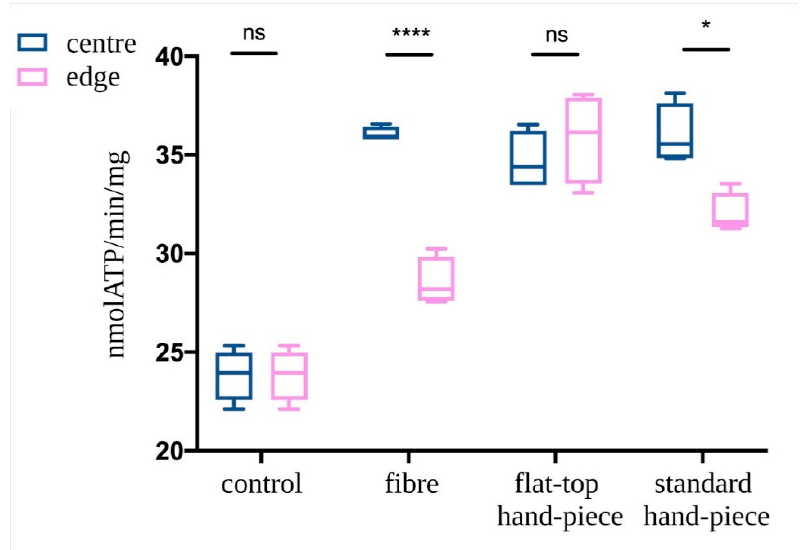
Figure 5. Effect of the photobiomodulation on mitochondrial ATP synthase activity. The isolated mitochondria were placed at the centre or edges of the laser treatment spot (1 cm 2 ) and the treatments were performed using a fibre, flat-top hand-piece or a standard hand-piece. All samples were treated with PBM 808 nm laser in continuous wave mode with 1 W, 1 W/cm 2 , 60 J and 60 J/cm 2 for 60 s. Untreated control samples were placed in a similar set-up with laser at 0 W for 60 s. Data are expressed as mean ± SD. A significant difference between the ATP production of the mitochondria in the centre vs. the edge is indicated by the symbol * and ****, respectively p < 0.05 and 0.0001, ns indicates a no-significant